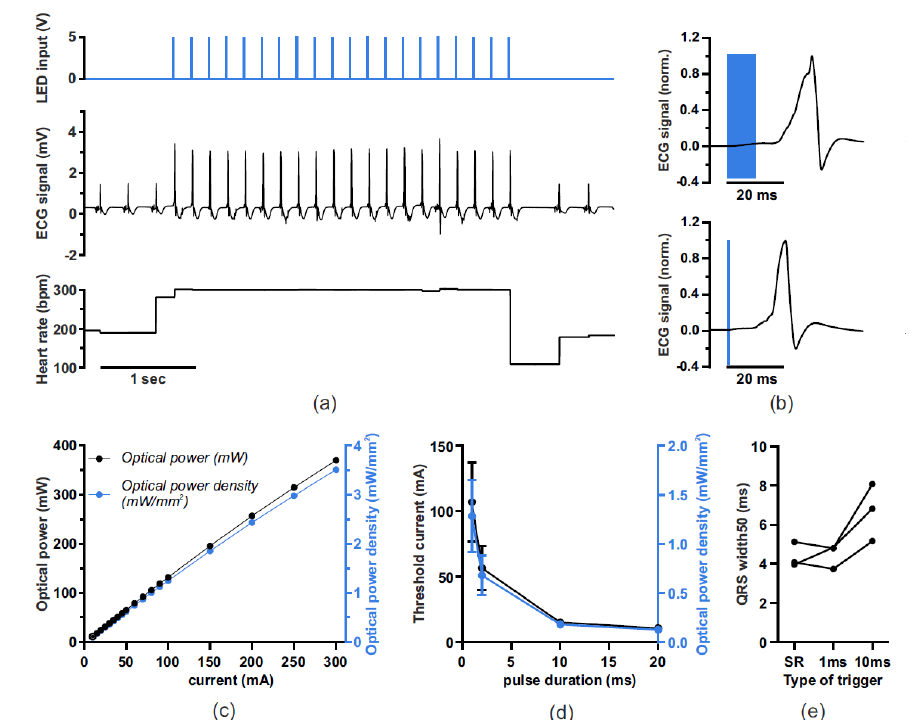
Figure 9. ( a ) Example trace for optogenetic pacing with the two LED matrix at 300 beats per minute (bpm) with 10 ms light pulses (blue line top indicating LED trigger), ECG traces (in mV, middle) and heart rate analysis (in bpm, lower). ( b ) Examples of QRS complexes triggered by 10 ms (top) and 1 ms (lower) light pulses (blue bars). ( c ) Measured optical power and estimated optical power density in dependence on the cumulative current applied to all LEDs from the two LED matrix (divide by 2 for individual LED current). ( d ) Analysis of threshold cumulative LED current and overall optical power density for reliable optogenetic pacing for different pulse durations. ( e ) Analysis of QRS duration during sinus rhythm (SR) and during optogenetic pacing with 1 ms and 10 ms light pulses from three different hearts (data points from each mouse heart connected by black